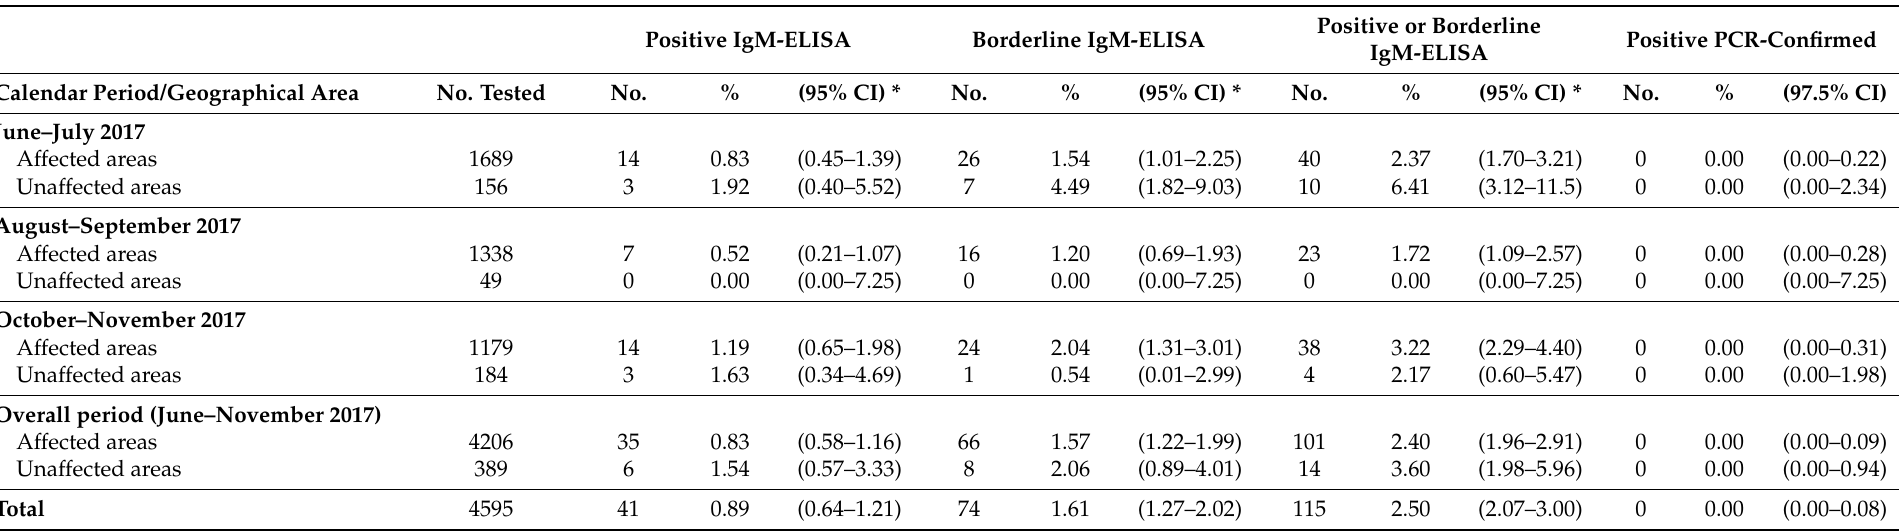
Table 2. Prevalence of Chikungunya virus among 4595 blood donors in the Lazio region (Italy, June–November